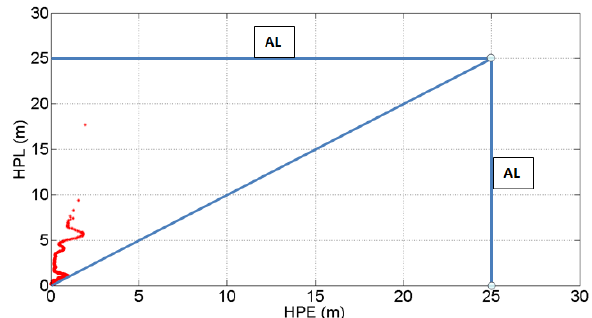
Figure 5. HPE and HPL correlation for Ocean/Coastal/Port approach/Inland waterway phase (after the convergence of the real-time IGS-RTS PPP-based GPS solution to the favorable performance – after 1 second).